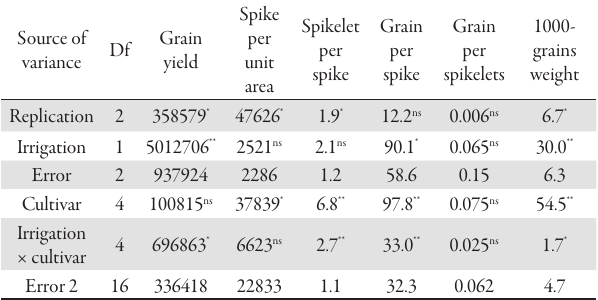
Tab. 1. Interactive effect of treatments, grain yields (kg ha -1 ) and yield components